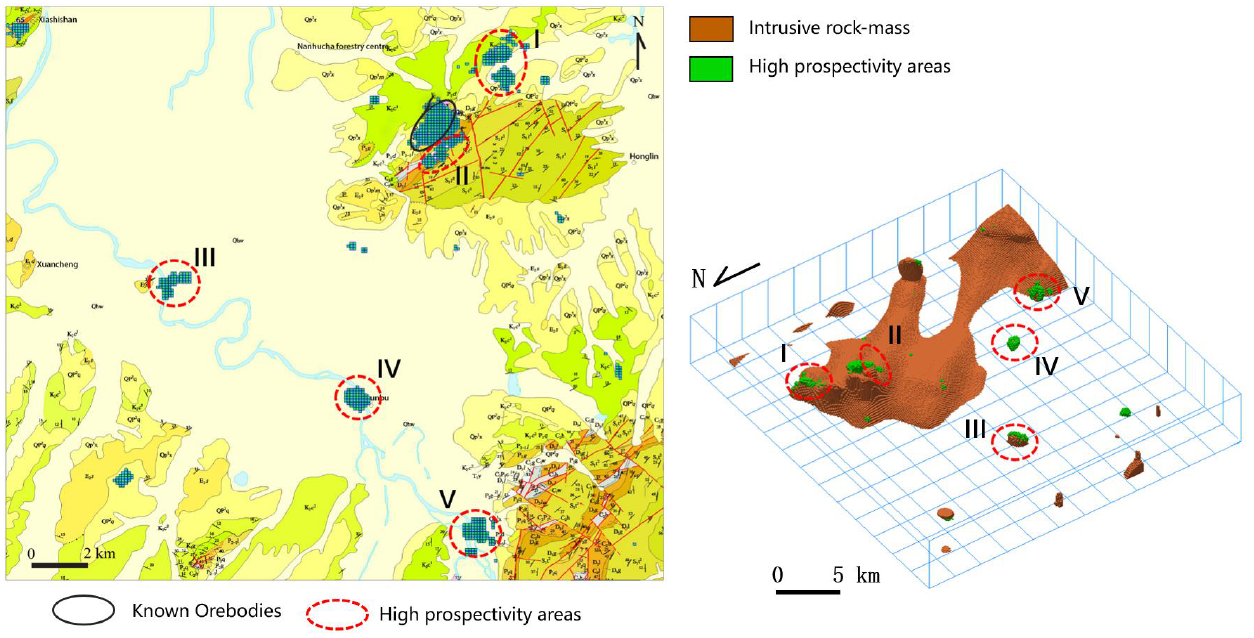
Figure 11. Delineation of prospecting target areas.